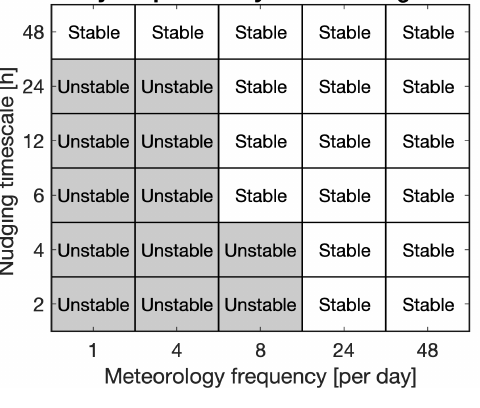
Figure 1. The stability of specified dynamics configurations over the full meteorology frequency/nudging timescale ranges examined here. “Stability” refers to whether the configuration requires an in- crease in the finite-volume advection subcycling. See text for de-